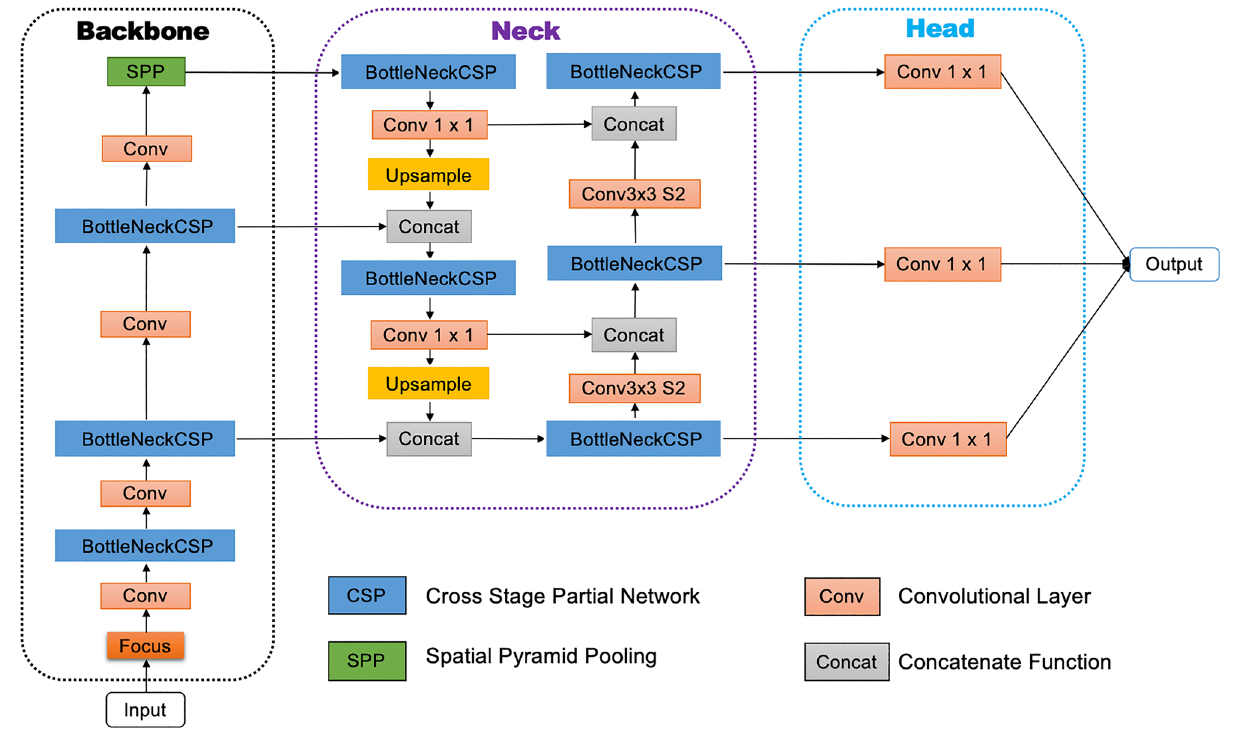
Figure 1. Network architecture. The figure shows the architectural diagram of YOLOv5 (default setting). It consists of three sections: (1) Backbone, (2) Neck, and (3) Head. Following preprocessing, images are first input to the Backbone for feature extraction, then are fed to the Neck for feature fusion and finally processed by the Head network to generate a model and output detection results (class, score, location, network (FPN) structure with enhanced bottom-up path to improve the propagation of low-level features. Next, the Head section generates image features of 3 different sizes, namely 18 × 18 , 36 × 36 and 72 × 72 pixels, so that the algorithm can capture structures occurring at different spatial scales in the image. The extraction of multiscale image features, which is a well-established approach in image analysis, is important to ensure accurate detection for complex objects such as astrocytes, as they include elongated processes occurring over a range of spatial scales (in our images, astrocyte processes exhibit lengths varying typically between 10 and 50 pixels). Based on the predictions of the Head section, the output layer produces bounding box coordinates for the detected objects together with detection scores and class probabilities . In our case, since there is only one class of objects (the astrocytes) the output only consists of bounding box coordinates with the corresponding detection scores, where a detection score is a number between 0.0 and 1.0. The value of the detection score measures the level of confidence that the bounding box actually contains an object of interest, with detection score 0.0 being the the lowest level of confidence and 1.0 being the highest one. Finally, the user chooses a confidence threshold